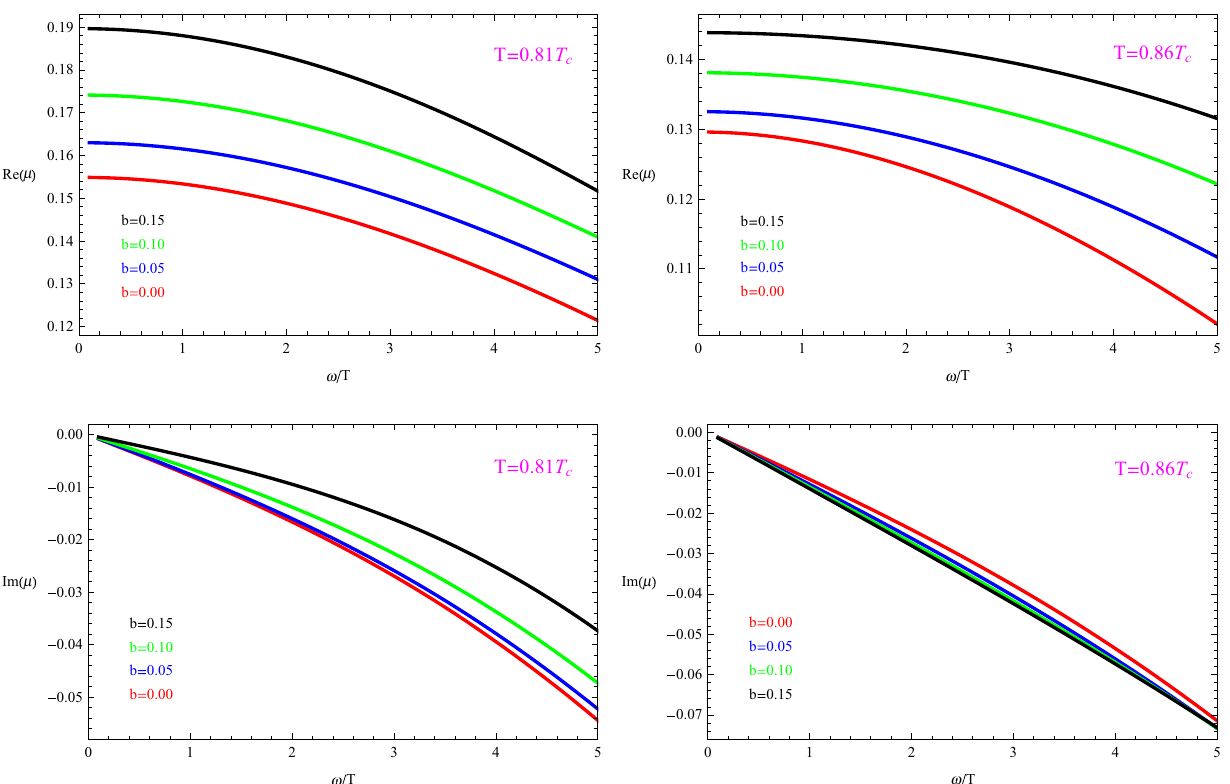
Fig. 3 The permeability μ as a function of ω/ T with the fixed temperatures T = 0 . 81 T c (left) and T = 0 . 86 T c (right) for different values of the Born–Infeld parameter b . The four lines in each panel correspond to the Born–Infeld parameter b = 0 . 00 (red), 0 . 05 (blue), 0 . 10 (green) and 0 . 15 (black), respectively